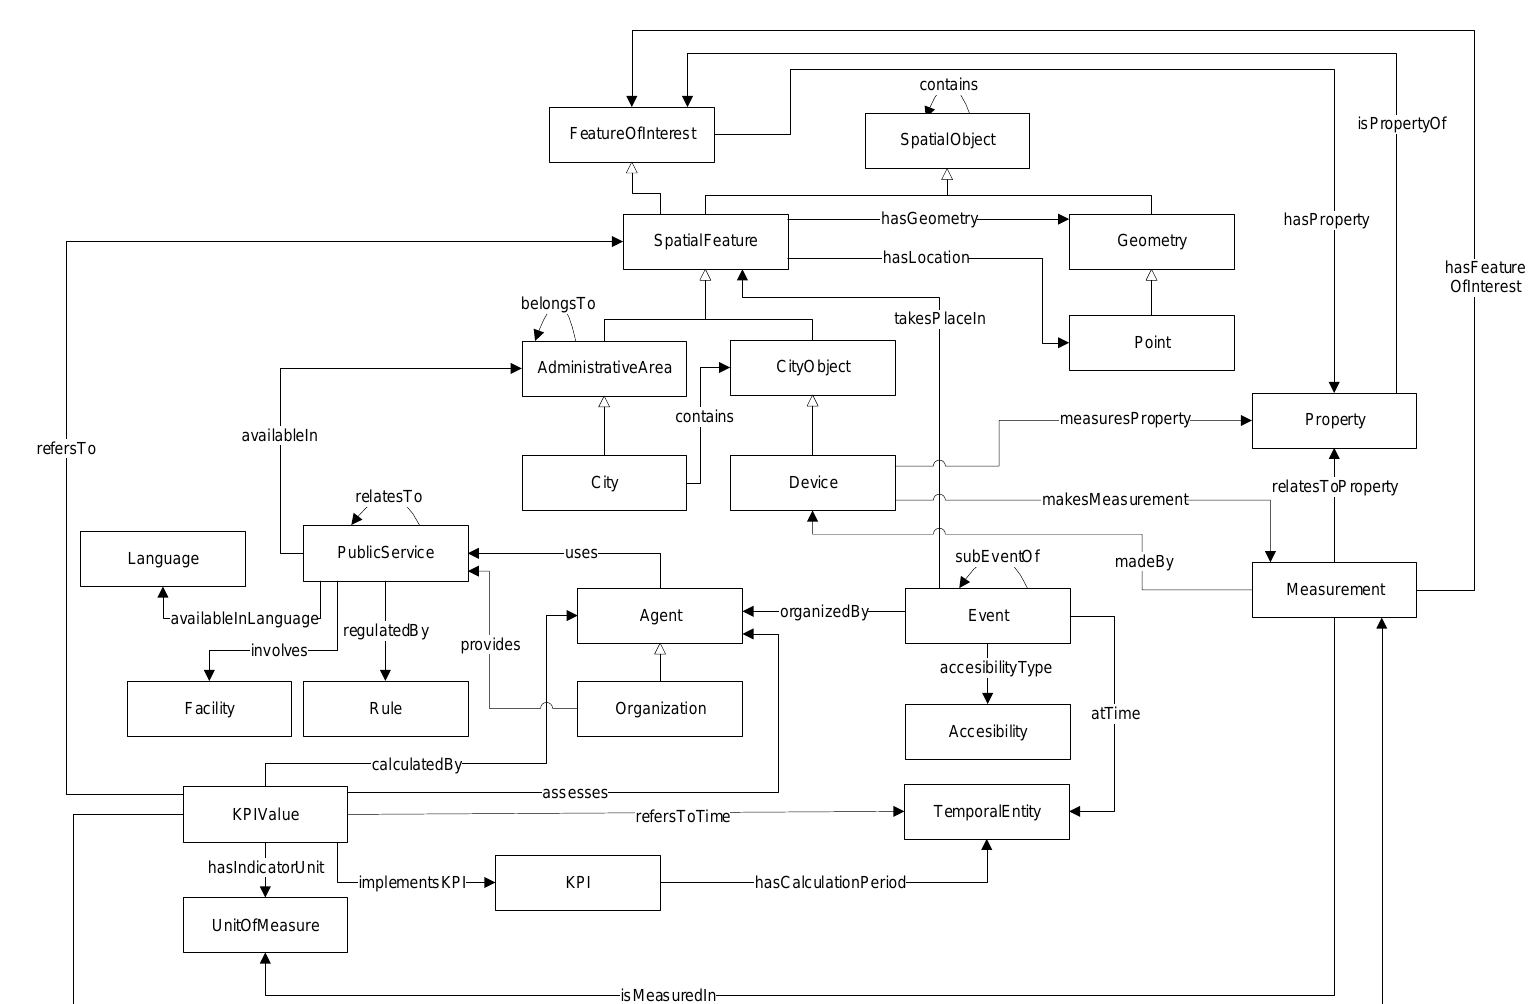
Figure 3. Smart city ODP